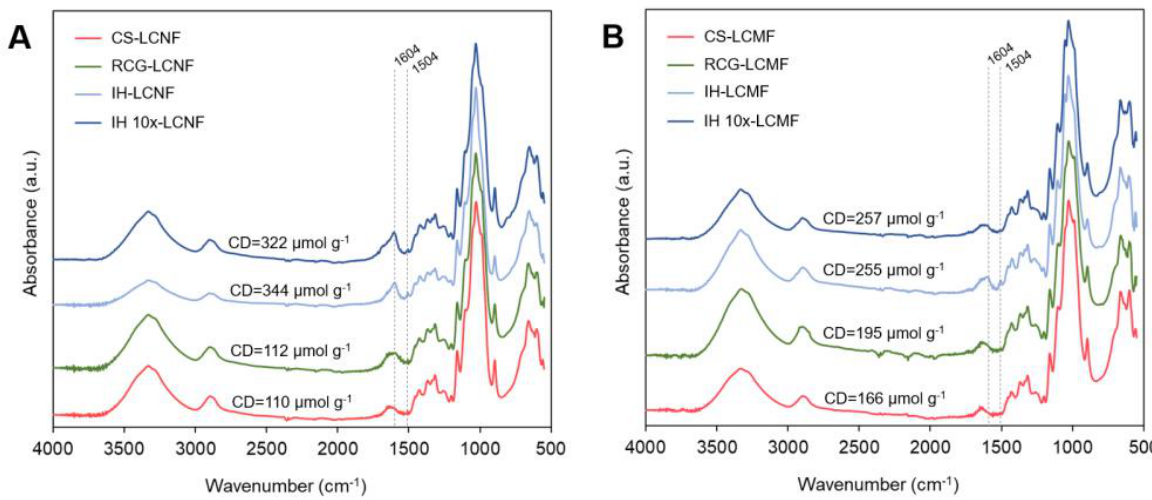
Figure 4. FTIR spectra showing specific chemical bonds of ( A ) LCNFs and ( B ) LCMFs of different biomass feedstocks. Charge density (CD) values obtained via conductometric titration are also shown (the titration curves are shown in Supporting Information, Figure S2).